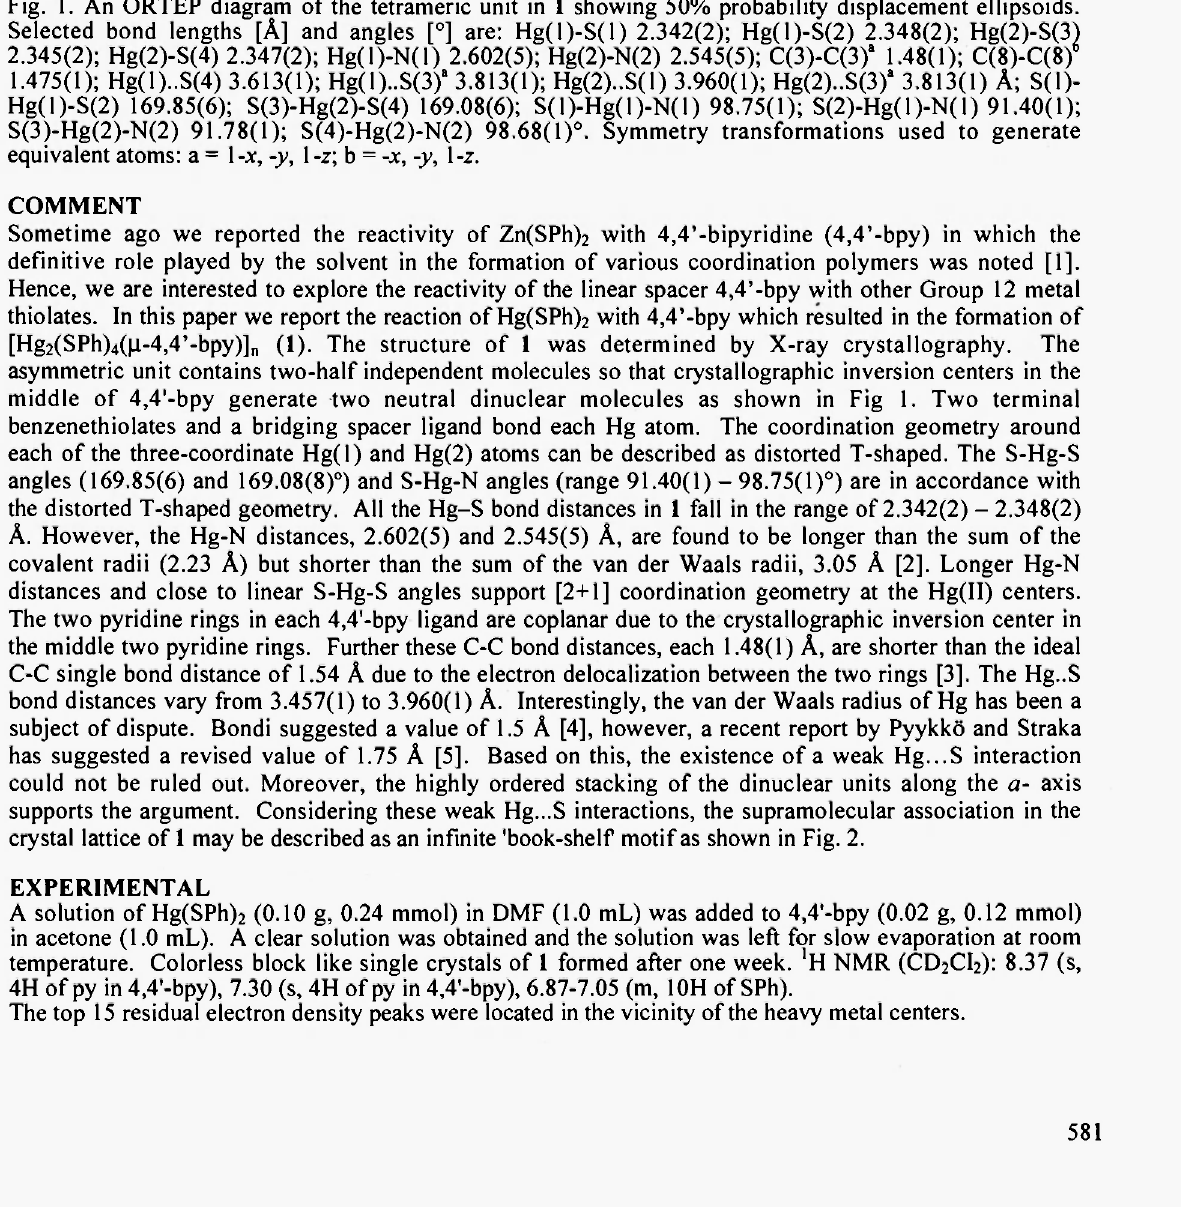
Fig. 1. An ORTEP diagram of the tetrameric unit in 1 showing 50% probability displacement ellipsoids. Selected bond lengths [A] and angles [°] are: Hg(l)-S(l) 2.342(2); Hg(l)-S(2) 2.348(2);